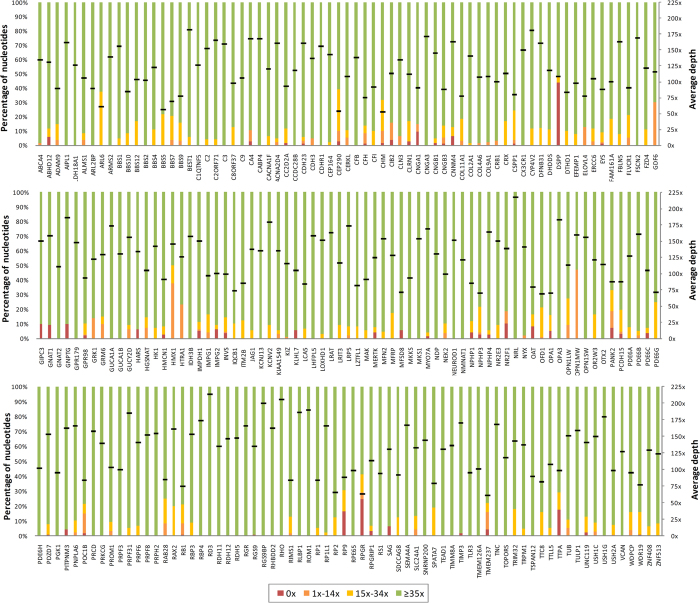
Coverage statistics of coding regions of genes included in the panel.The percentage of nucleotides with 0x, 1x–14x, 15x–34x, or ≥35x depth coverage per gene is shown. Black lines represent the average depth in each case.